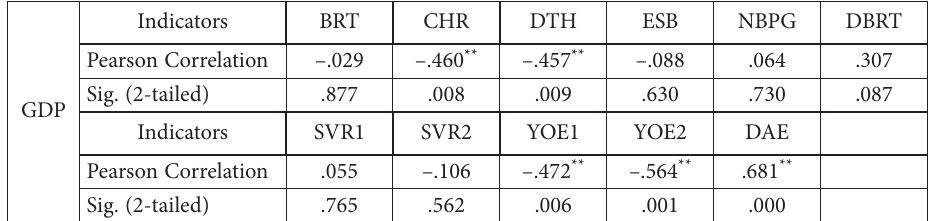
Table 5. The values of Pearson Correlation between GDP and factorial variables for Cluster A Indicators BRT CHR DTH ESB NBPG DBRT Pearson Correlation –.029 –.460 ** –.457 ** –.088 .064 .307 Sig. (2-tailed) .877 .008 .009 .630 .730 .087 GDP Indicators SVR1 SVR2 YOE1 YOE2 DAE Pearson Correlation .055 –.106 –.472 ** –.564 ** .681 ** Sig. (2-tailed) .765 .562 .006 .001 .000 Note : ** Correlation is significant at the 0.01 level